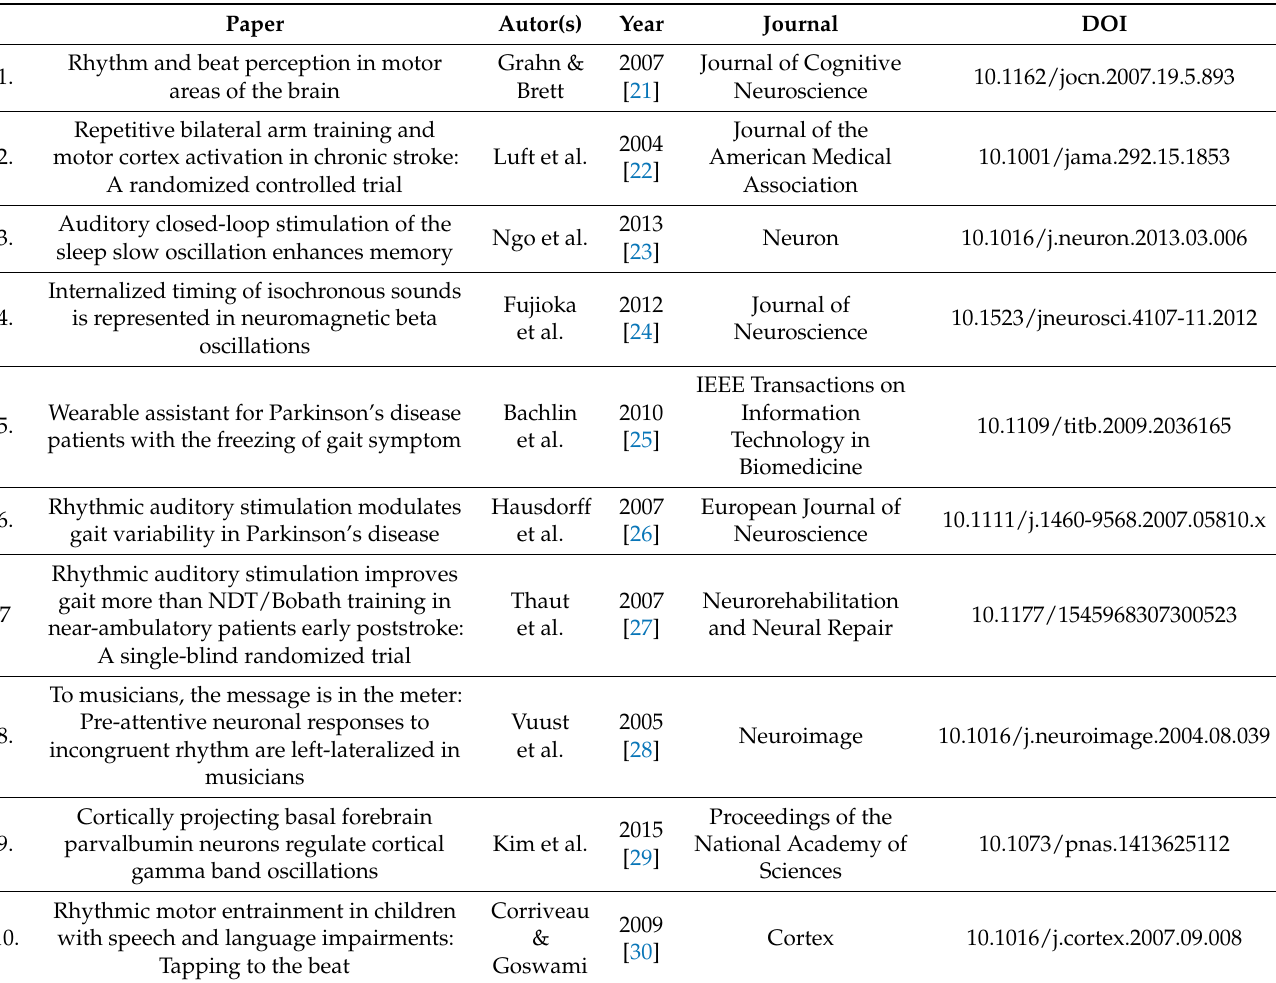
Table 4. The top 10 most-cited articles during 2001–2020.